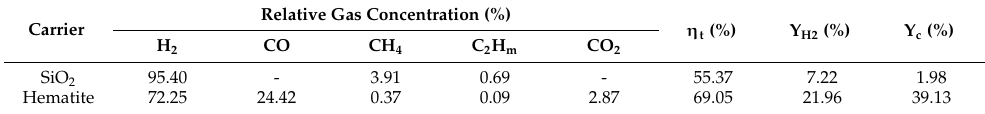
Table 2. The role of hematite in benzene cracking.